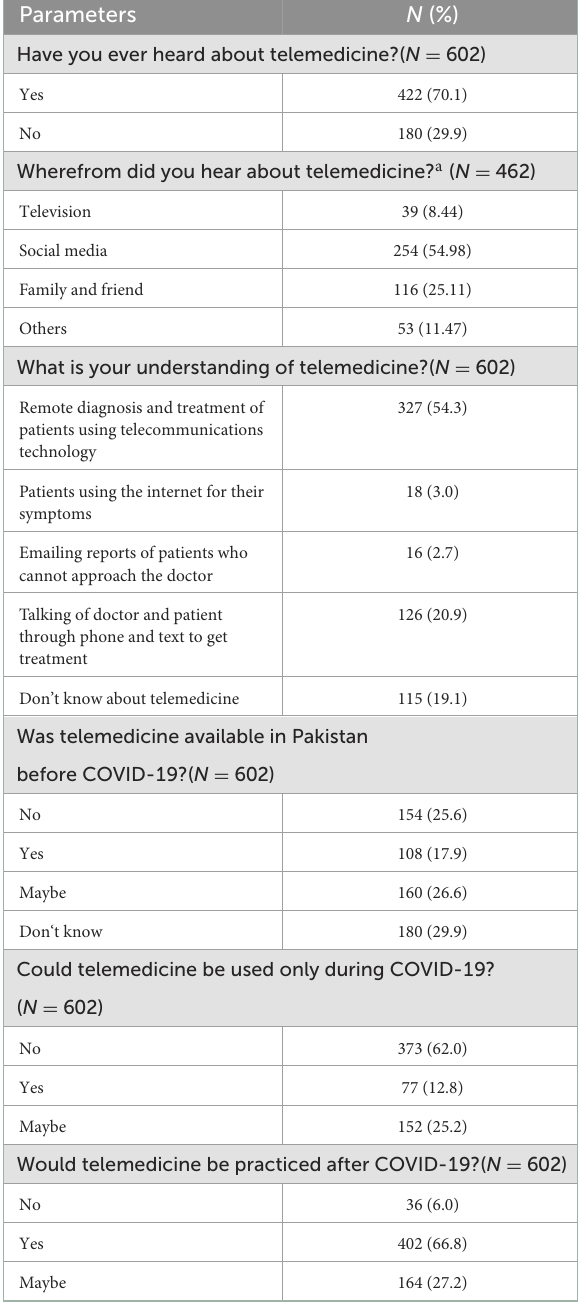
TABLE 2 Knowledge and impact of COVID-19 on knowledge related to telemedicine service. Parameters